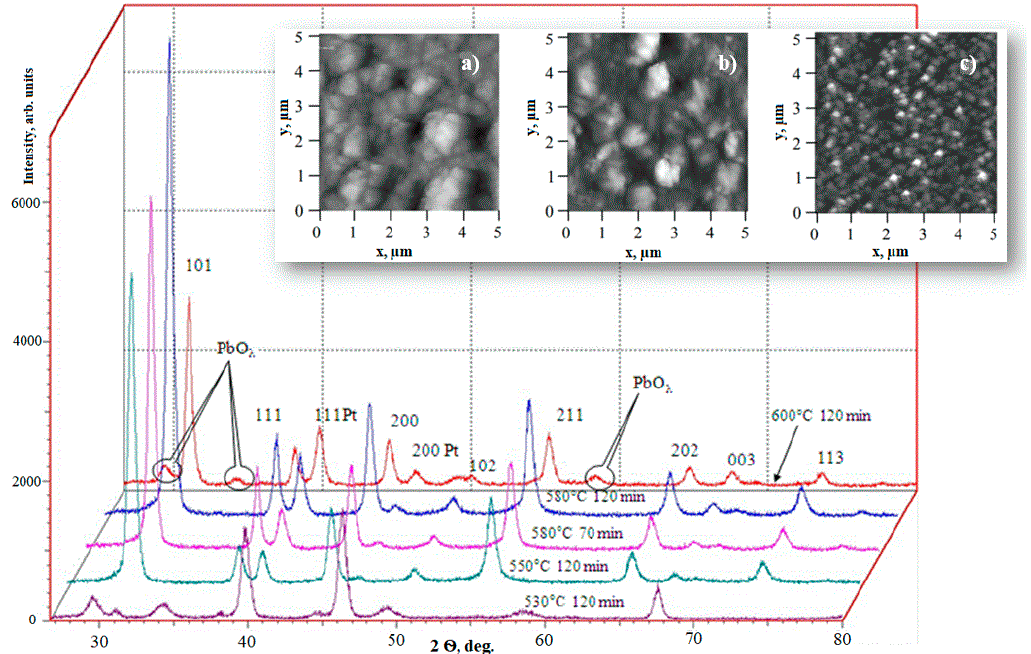
Figure 2. X-ray diffraction patterns of PZT films of 1.5 µm thickness formed at different temperatures and times of treatment in an oxygen-containing medium. The inset shows the surface morphology of PZT films after heat treatment in the following conditions: ( a ) 580 °C for 70 min; ( b ) 580 °C for 120 min; ( c ) 600 °C for 120 min.